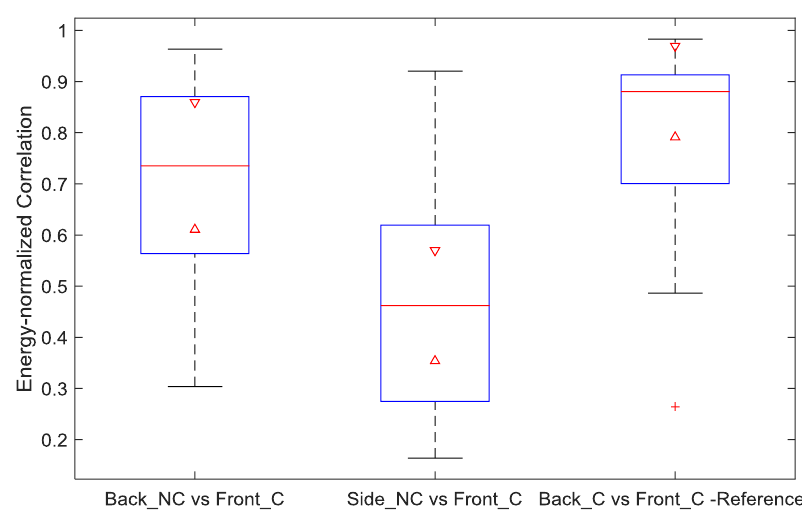
Figure 6. Correlation boxplot. Left box shows the correlation between ccECG from the back and contact ECG from the front; middle box shows the correlation between ccECG from the side (left and right) and contact ECG from the front; right box shows the correlation between contact ECG from the back and contact ECG from the front for reference on the maximum similarity of signals obtained with the same method from these two locations. ccECG signals evaluated correspond to the collection of every best segment per measurement. NC: Non-Contact; C: Contact.